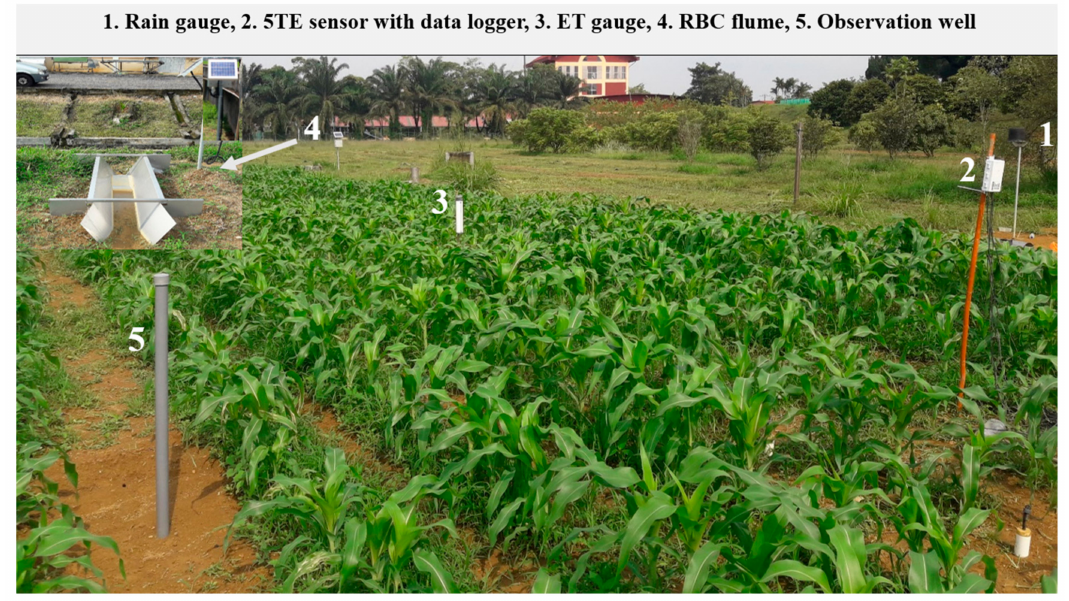
Figure 2. A view of the installation of di ff erent equipment in the